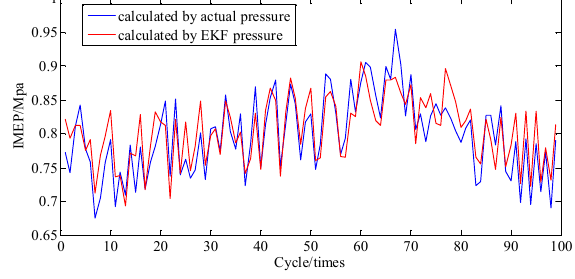
Figure 11. IMEP at A/F ratio 0.85 per cycle.